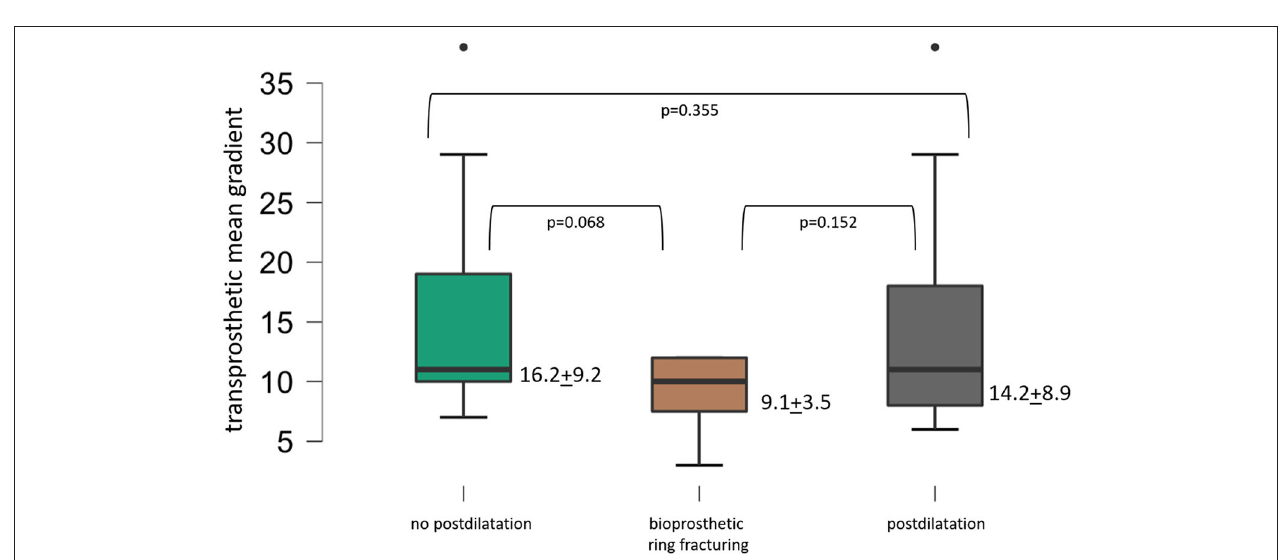
FIGURE 3 | Mean transprosthetic gradient after ViV-TAVR with small surgical valves.